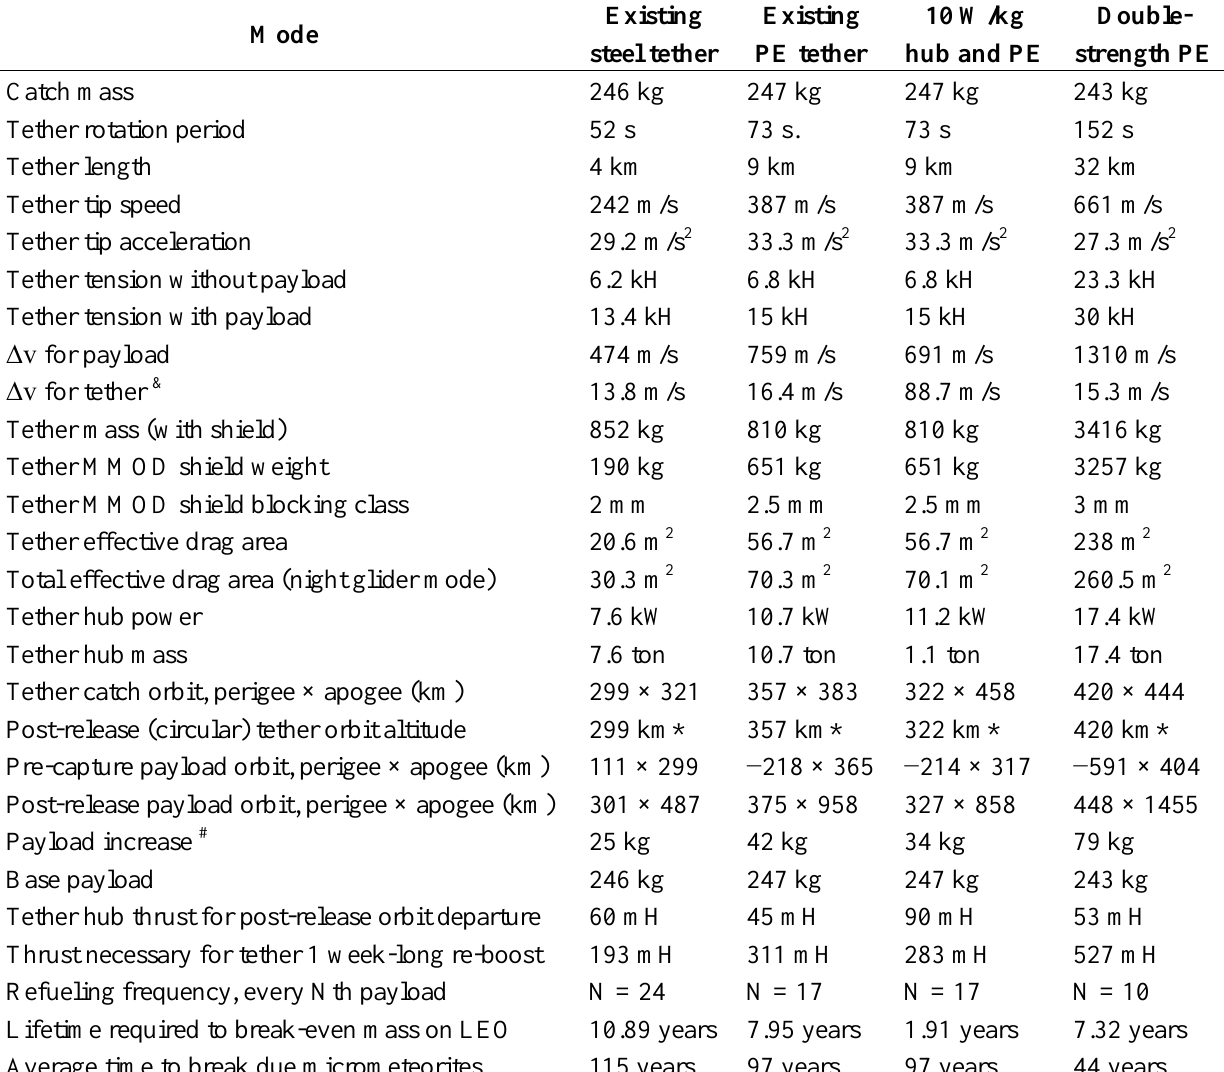
Table 3. The space launch mission budgets using momentum transfer tethers (bolo) on